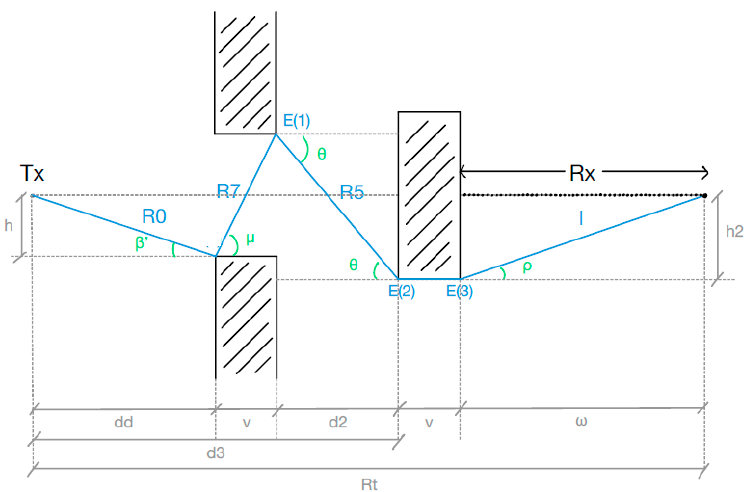
Figure 27. Sixth quadruple diffraction (Edif_q6) of the second considered NLOS scenario.